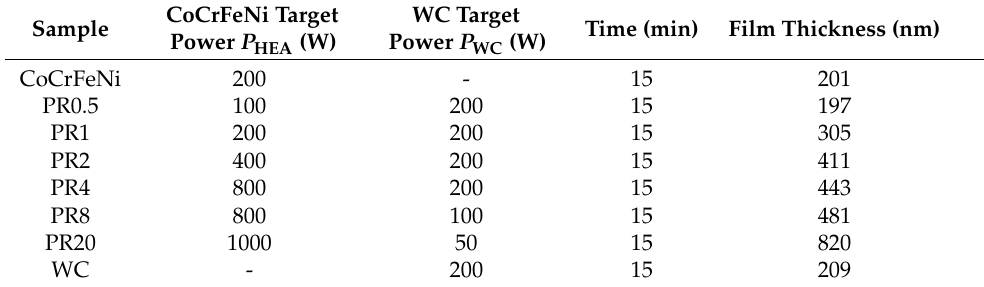
Table 1. Deposition parameters for the discussed samples (the time values refer to the actual deposition time excluding